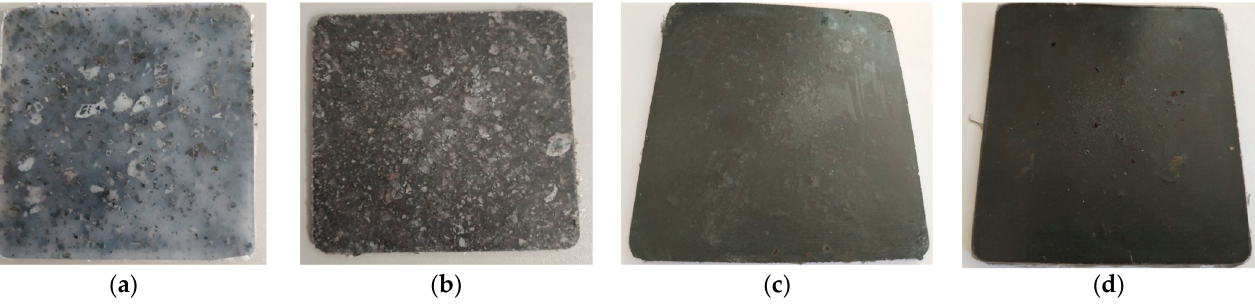
Figure 5. Examples of samples with the content of milled scale flakes at ( a ) 20%, ( b ) 80%, and mill scale powder at ( c ) 20%, ( d ) 60%.